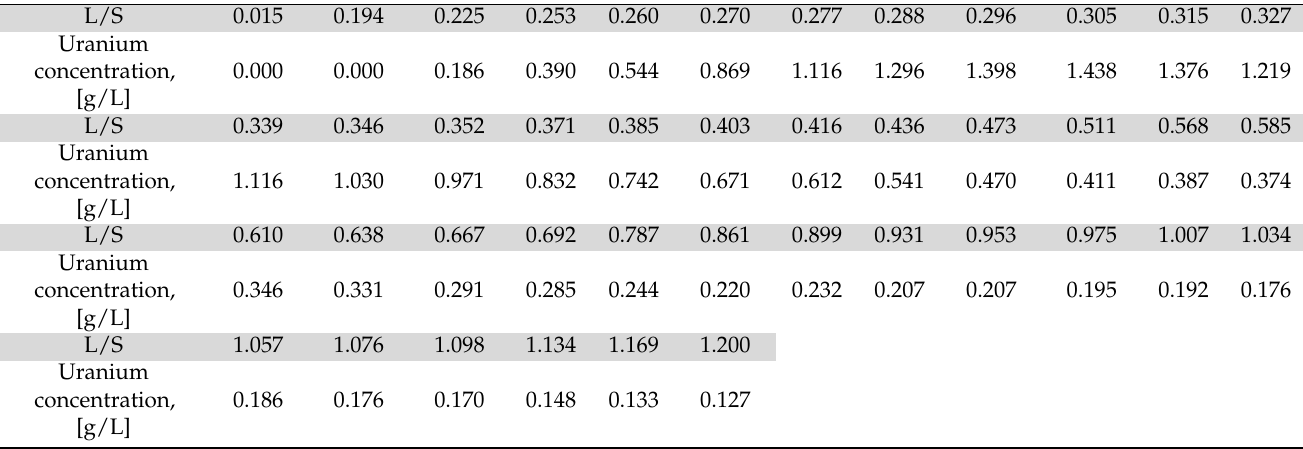
Table A2. Experimental data on dissolved uranium concentration at the tube outlet (Experiment 2: H 2 SO 4 = 20